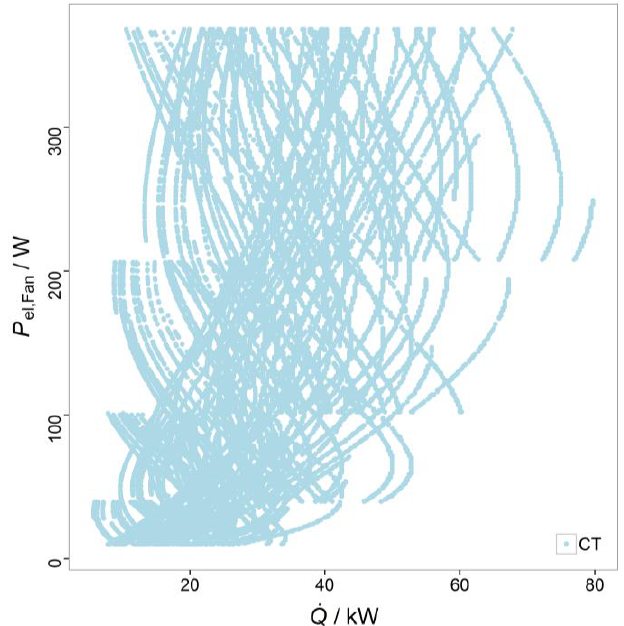
Figure 10. Electric power for fans ( 𝑃 ) versus rejected heat ( 𝑄̇ ) for simulated wet el,Fan cooling tower Type 51 in TRNSYS 17. This depiction is not suitable to compare performance of heat rejection units.